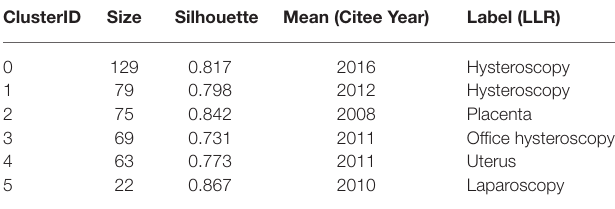
TABLE 5 | The analysis of the top 6